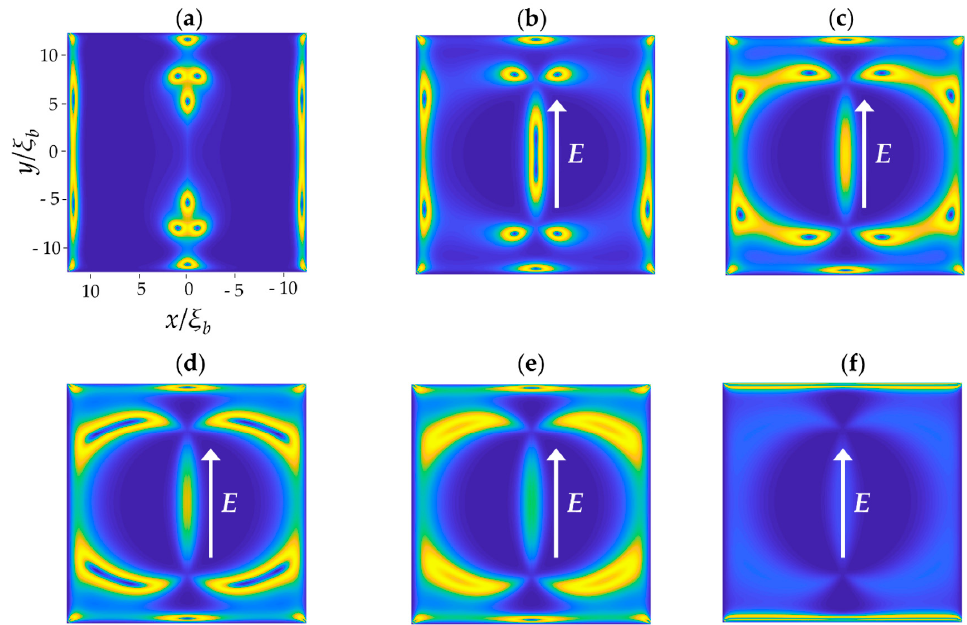
Figure 6. Annihilation by increasing an external in-plane electric field. 2D biaxiality profiles β 2 ( x , y ) are shown. We gradually increase the external electric field in the y-direction. ( a ) µ f = 0, ( b ) µ f = 0.4, ( c ) µ f = 0.7, ( d ) µ f = 0.85, ( e ) µ f = 1, ( f ) µ f = 3.5. R / ξ b = 25, t = − 8. Selected corresponding